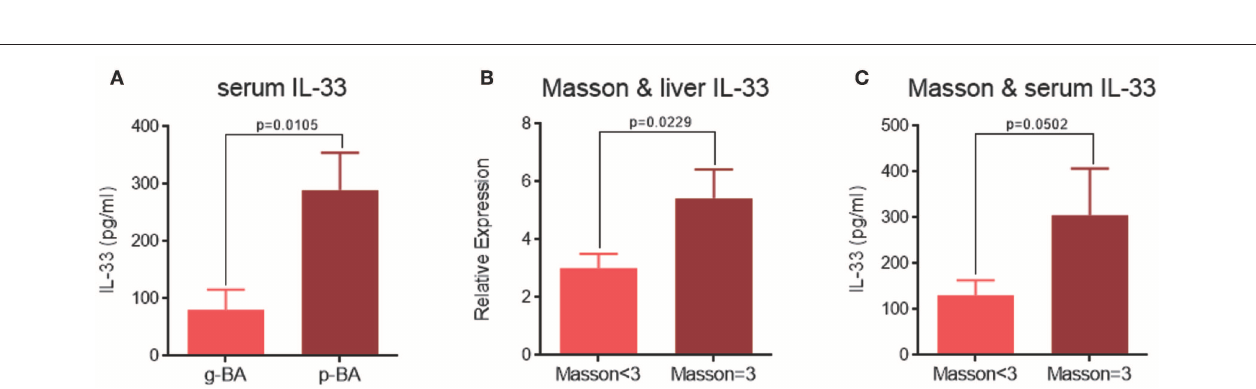
FIGURE 2 | Subgroup analyses between g-BA and p-BA groups. mRNA expression levels of IL-33 (A) , ST2 receptor (B) , and TGF- β 1 (C) in g-BA and p-BA livers. Quantification in IHC staining of IL-33 (D) , IL-13 (E) , and TGF- β 1 (F) expression in g-BA and p-BA livers. (G) Mast cell count in the liver of two BA subgroups.